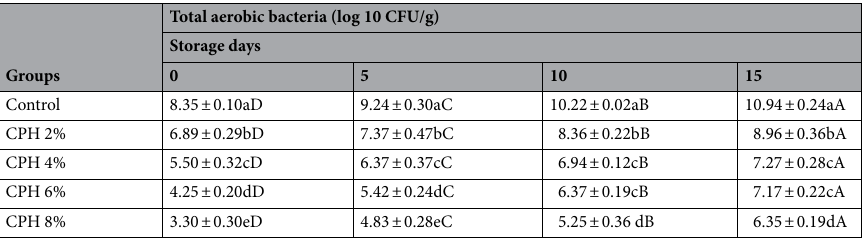
Table 9. Total aerobic bacteria (TAB) of casein protein hydrolysate (CPH) powder incorporated raw beef nuggets. CPH: casein protein hydrolysate. All the values are means of triplicate determinations ± Standard Deviation (SD). Means within the column with different small letters are significantly different (p < 0.05) and different capital letters within the row differed significantly.